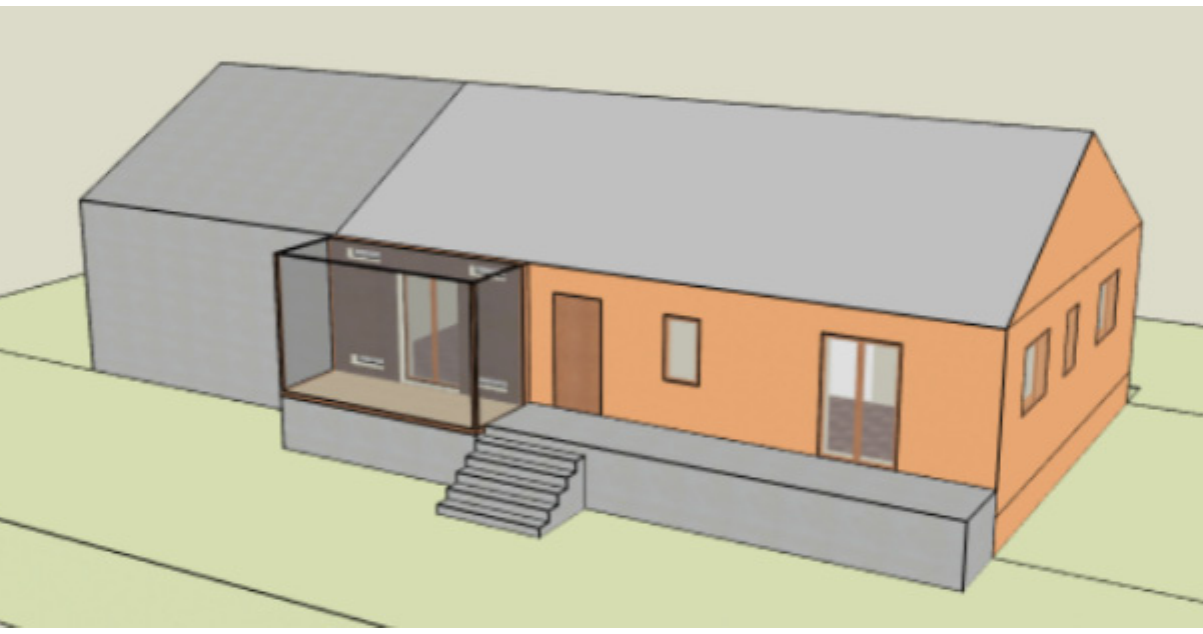
Figure 4. Reference building model with the attached sunspace.